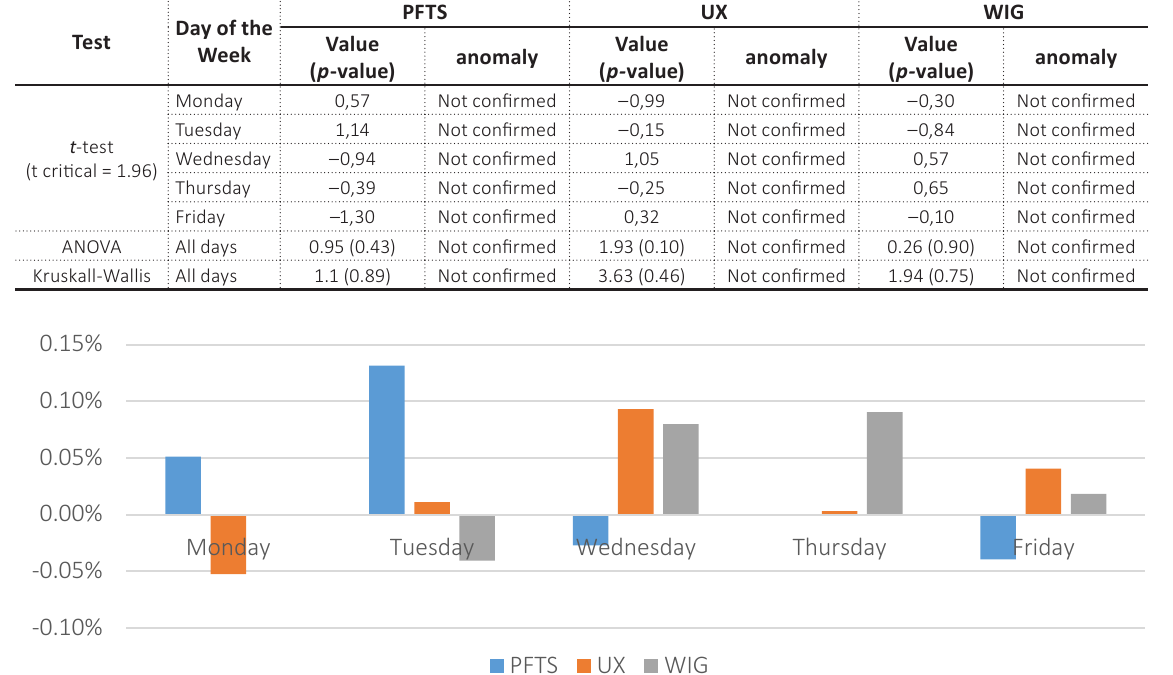
Figure 3. Average returns for the different days of the week